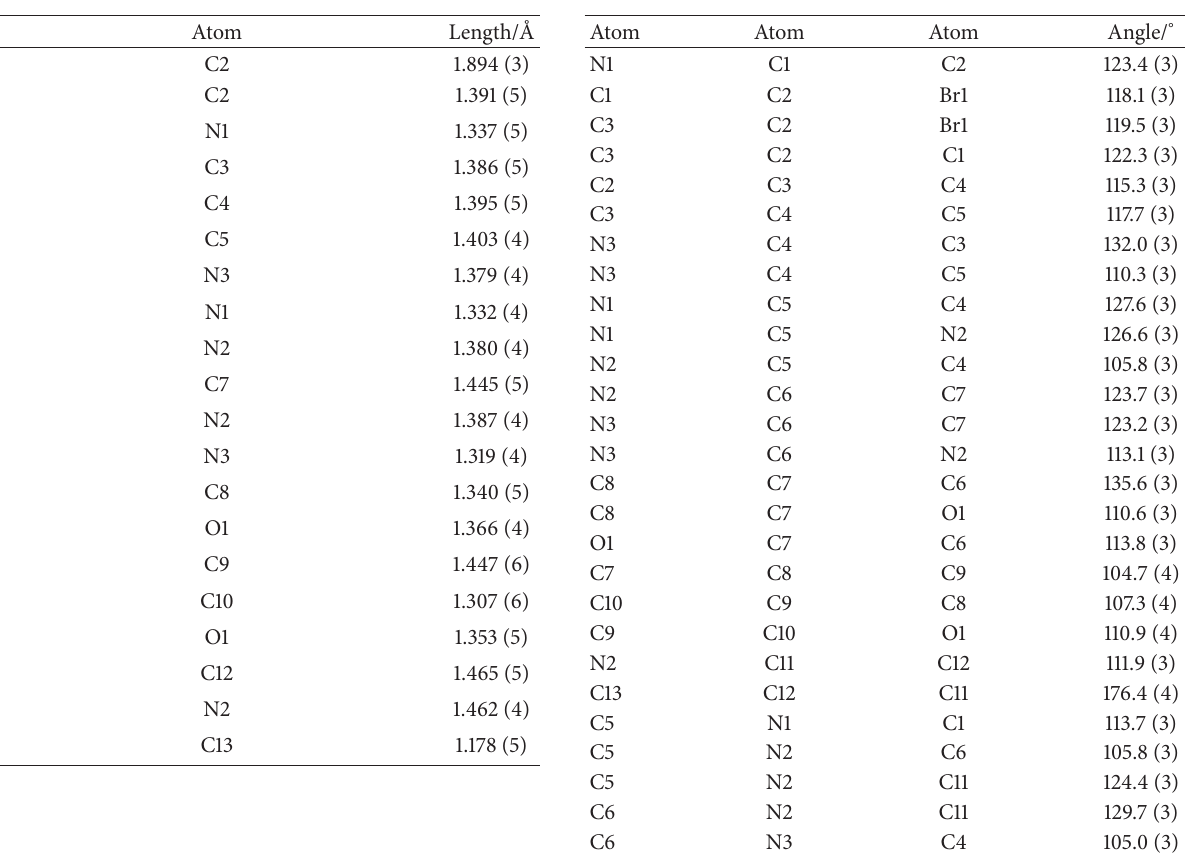
Table 2: Bond lengths for compound 1 . Table 3: Bond angles for compound 1